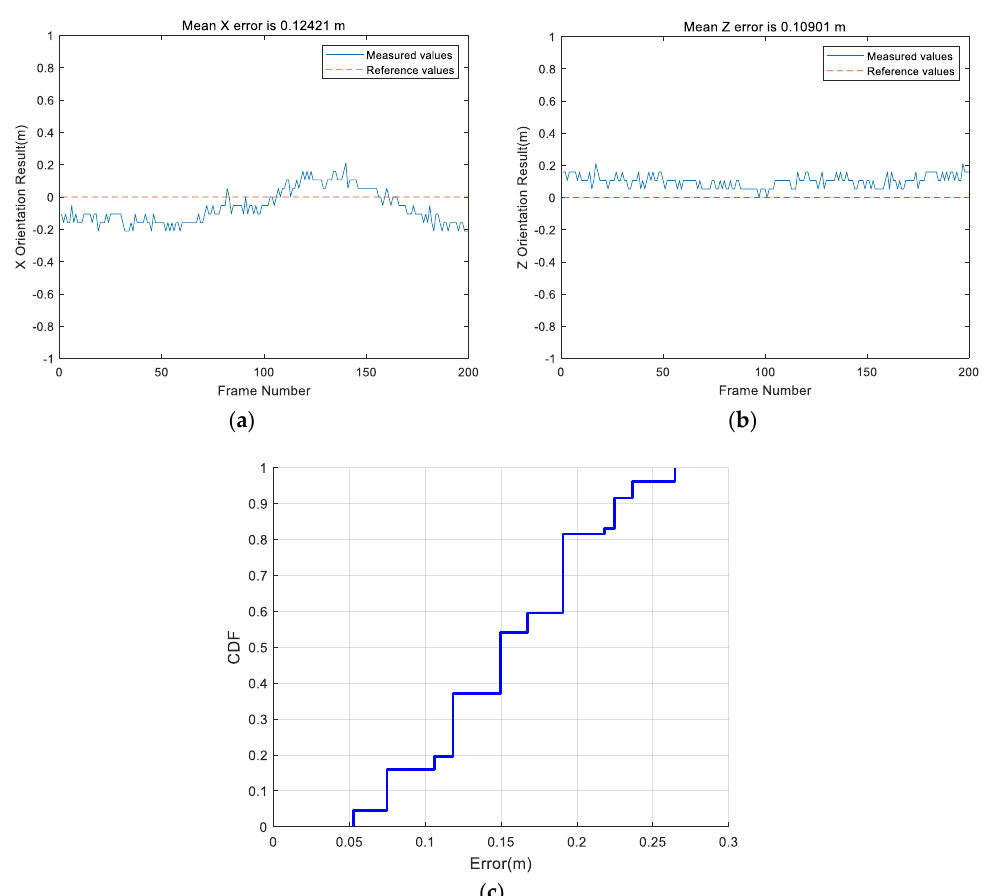
Figure 10. The source rotation test positioning results at the point (0, 0). ( a ) Error in the x–direction. ( b ) Error in the z–direction. ( c ) CDF.